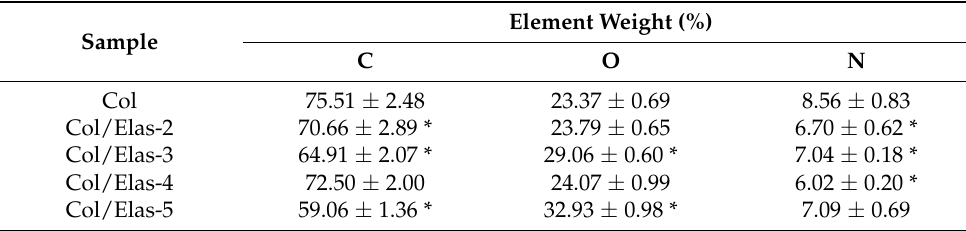
Table 1. Elemental analysis by EDX in Col/Elas scaffolds. (*) represents a significant difference ( p < 0.05; n = 3) from the control group, Col.